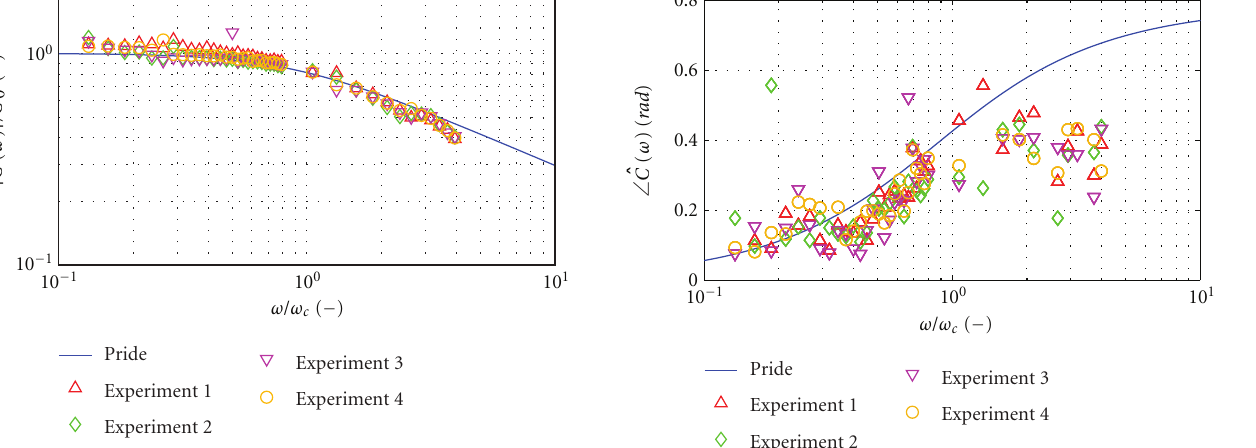
Figure 7: Amplitude of the normalized dynamic SP coe ffi cient. Theory of Pride [29] versus measurements, using the parameters as shown in Table 1 and assuming σ ( ω ) = σ 0 . Experiments 1–4 denote repeated experiments at di ff erent times.